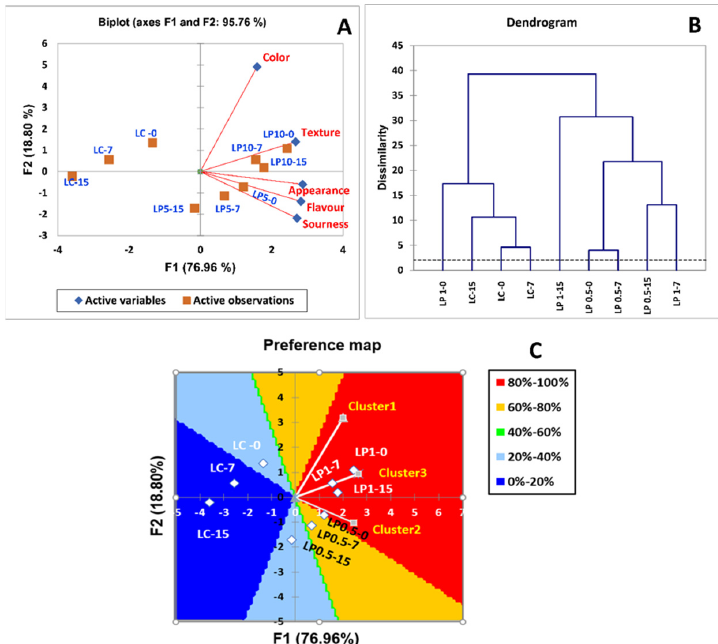
Figure 3. ( A ) Representation of attributes and samples in the first two dimensions of the correspondence analysis (CA) of labneh enriched with PFPP. ( B ) Dendrogram derived from the hierarchical cluster analysis (HCA) on the representation of labneh enriched with PFPP. ( C ) Contour plot of preference and preference map of consumers clusters for different treatments: LC ‐ 0 (Labneh without PFPP at day 0), LC ‐ 7 (Labneh without PFPP after 7 days of storage), LC ‐ 15 (Labneh without PFPP after 15 days of storage), LP 0.5 ‐ 0 (Labneh with 0.5% of PFPP at day 0), LP 0.5 ‐ 7 (Labneh with 0.5% of PFPP peel after 7 days of storage), LP 0.5 ‐ 15 (Labneh with 0.5% of PFPP after 15 days of storage), LP 1 ‐ 0 (Labneh with 1% of PFPP at day 0), and LP 1 ‐ 7 and LP 1 ‐ 15 (Labneh with 1% of PFPP after 7 and 15 days of storage, respectively).